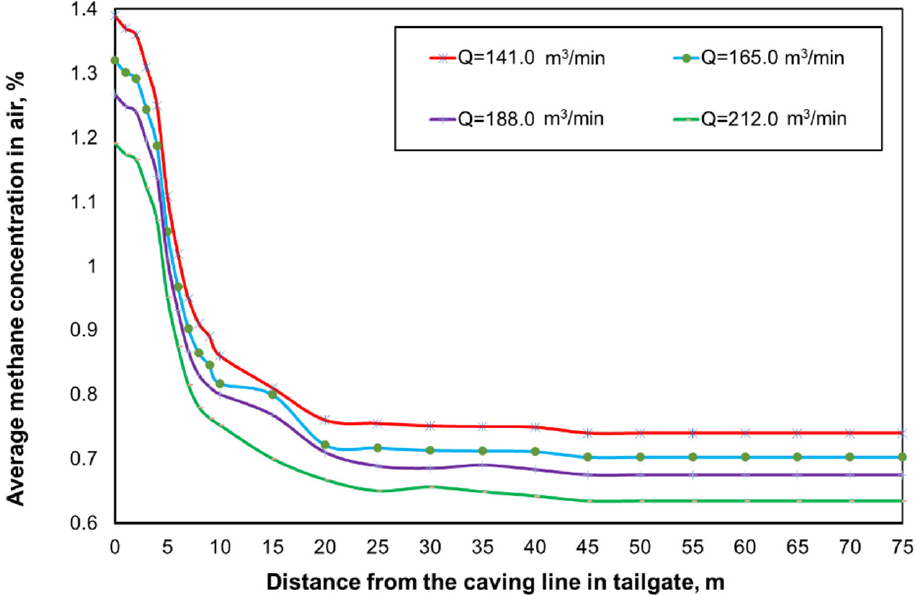
Figure 20. Average methane concentration values in the cross-sections of the tailgate for the analysed volume outputs of the air stream supplied along the auxiliary air duct.